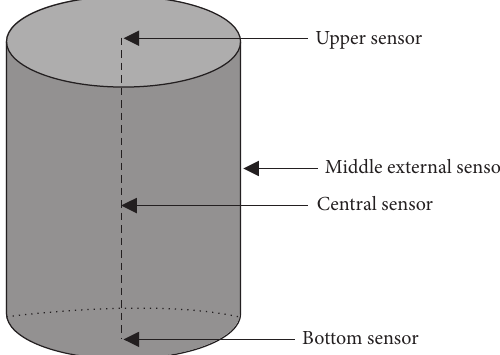
Figure 5: Schematic diagram showing the location of temperature sensors.